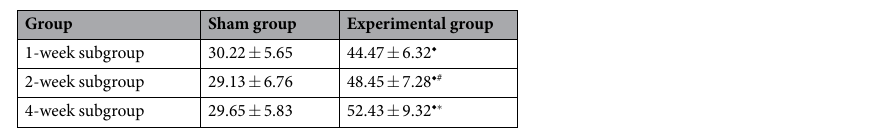
Table 2. WA/TA ratio in the rat CTEPH model. Note: Data are expressed as (mean ± SD)%. ◆ P < 0.05, compared to the same week in the sham group; # P < 0.05, compared to the 1-week experimental subgroup; ∗ P < 0.05, compared to the 1- and 2-week experimental